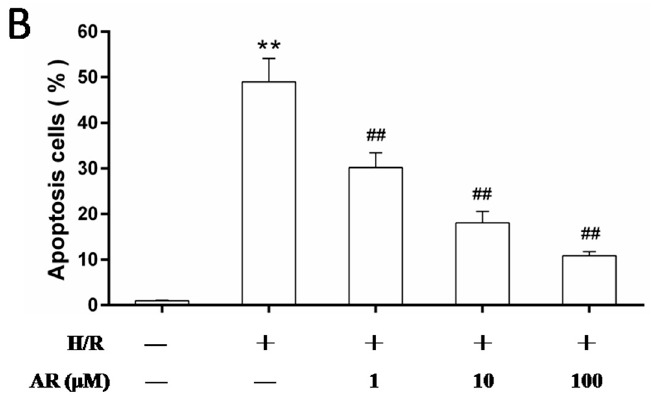
Figure 3. Effects of AR on H/R-induced H9c2 cardiomyocytes apoptosis. Flow cytometry analysis was